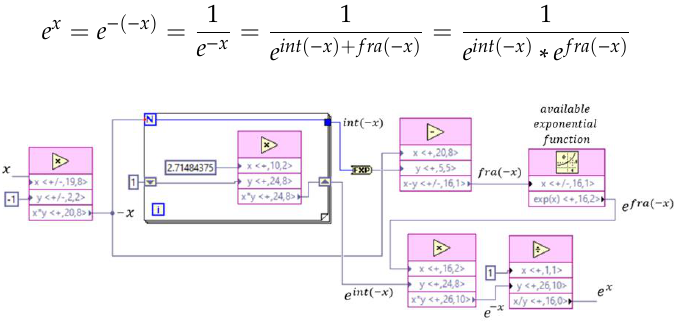
Figure 9. Algorithm to calculate powers of e less than − 1.